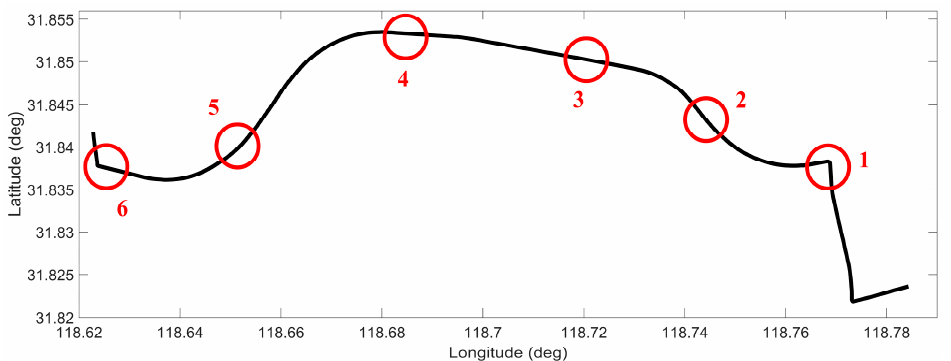
Figure 7. Road-test trajectory 1 with simulated GPS outages indicated.